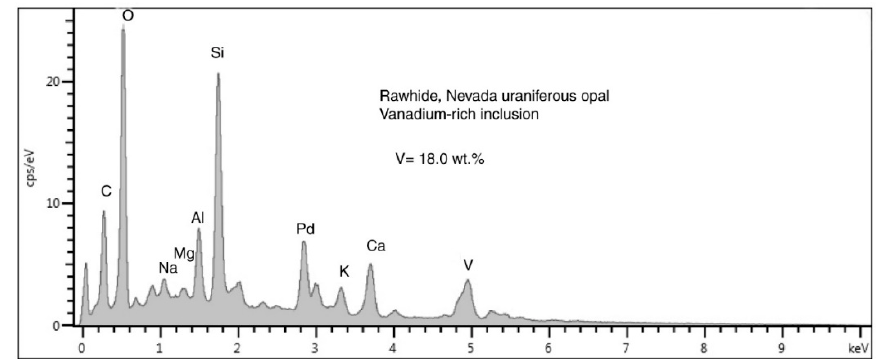
Figure 32. SEM/EDS spectrum of a single small vanadium mineral bleb lying on a plagioclase clast (Figure 22F). The tiny size of the vanadium-rich inclusion allows the electron beam to excite elemnts in the adjacent matrix. The Pd peak is an artifact from specimen coating. The unlabelled peak ner 0KeV is detector noise resulting form the low count rate.